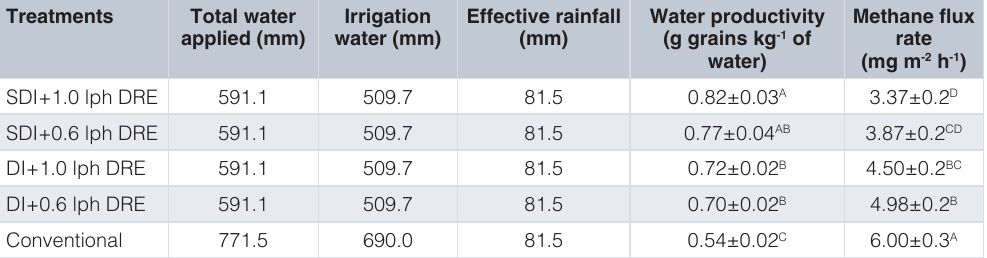
Table 2. Water usage, water productivity and methane flux (mg m -2 h -1 ) by different drip irrigation treatments and conventional aerobic rice growing seasons. Numbers in the table represent means ± standard deviation (n =3). Letters indicate significant differences (P<0.05) among means according to an